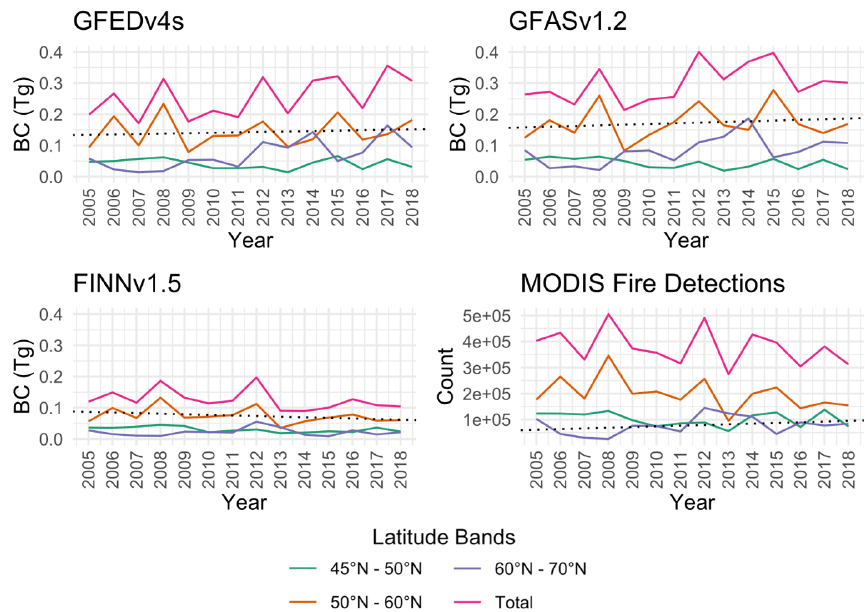
Figure 2. Annual black carbon (BC) emissions in teragrams from three commonly used global fire emissions models and annual fire activity from the MODIS Collection 6 active fire product (Terra and Aqua) split by latitude ranges for the Arctic Council region, 2005–2018; note the y axis has been standardized for each model for ease of comparison; the dotted line is the positive trend for BC emissions from open biomass burning and 1km MODIS active fire detections (Terra and Aqua) for 60 to 70 ◦